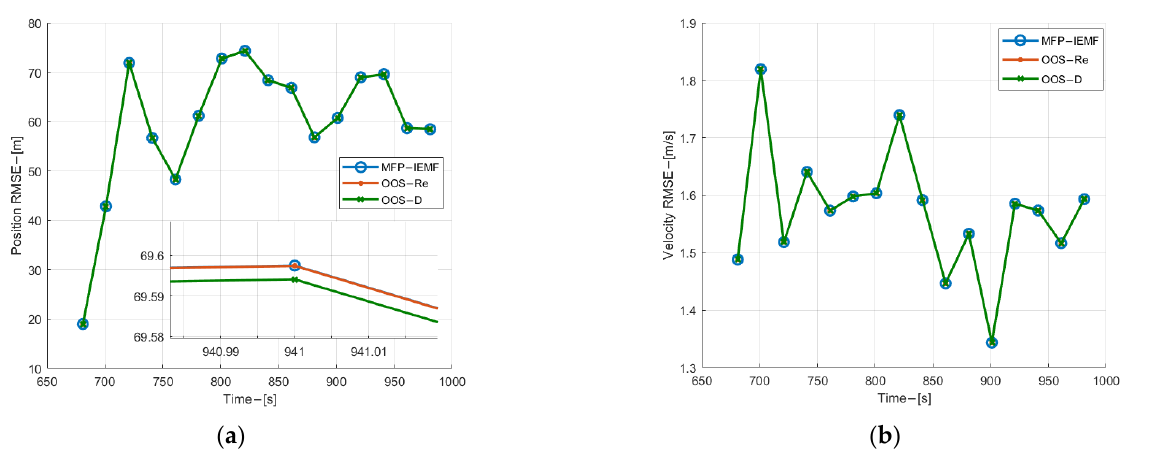
Figure 11. ( a ) Position estimation RMSE of submarine 1 with 35 lags; ( b ) velocity estimation RMSE for submarine 1 with 35 lags.